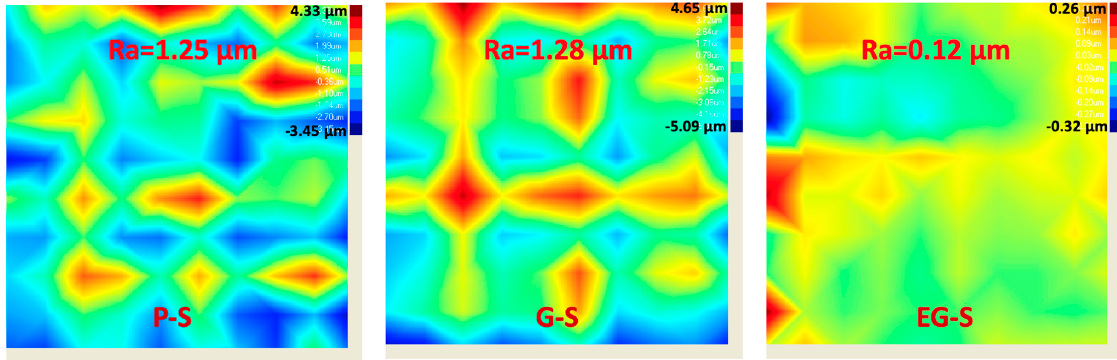
Figure 6. Surface profiles of the P-S, G-S, and EG-S fouled membranes (Roughness values also are provided on each figure). (Blue and red colors represent low fouling and high fouling thicknesses, respectively).